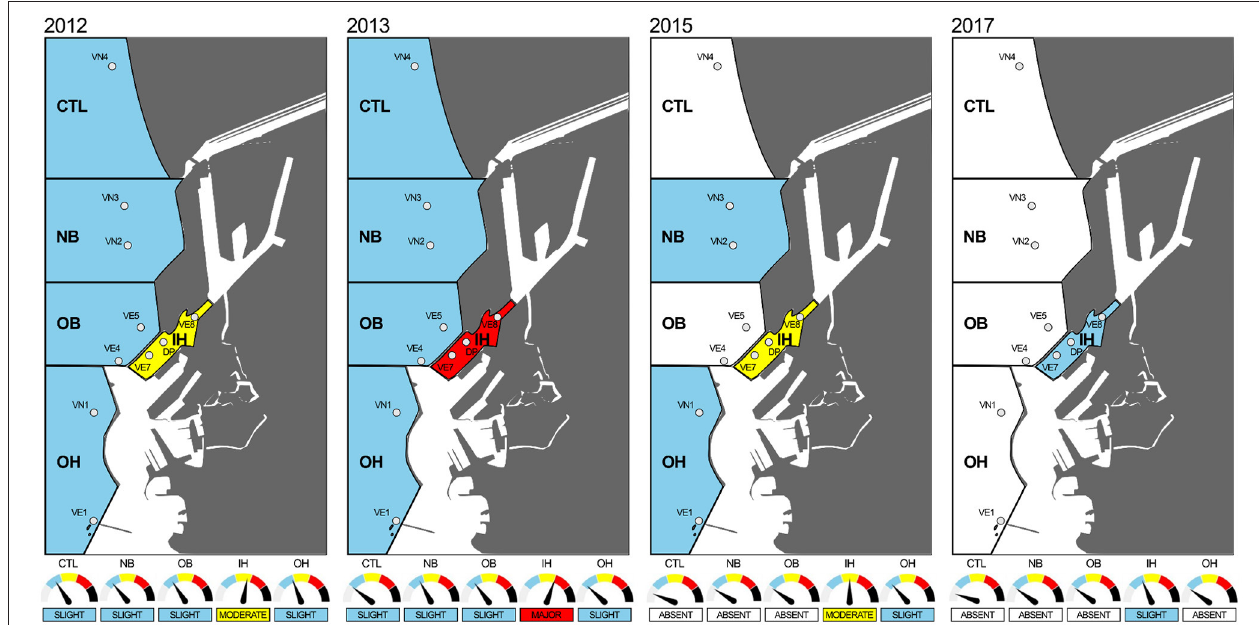
FIGURE 2 | Graphical representation of weighted elaboration. For each area during each campaign, colors are used to highlight risk class as follow: absent (white), slight (blue), moderate (yellow), major (red), and severe (black).